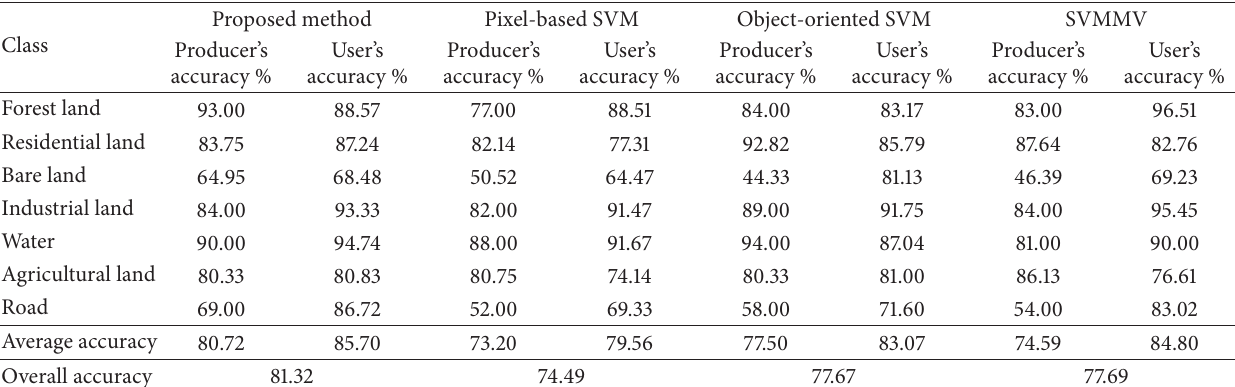
Table 3: Producer and user classification accuracies for SPOT-5 image